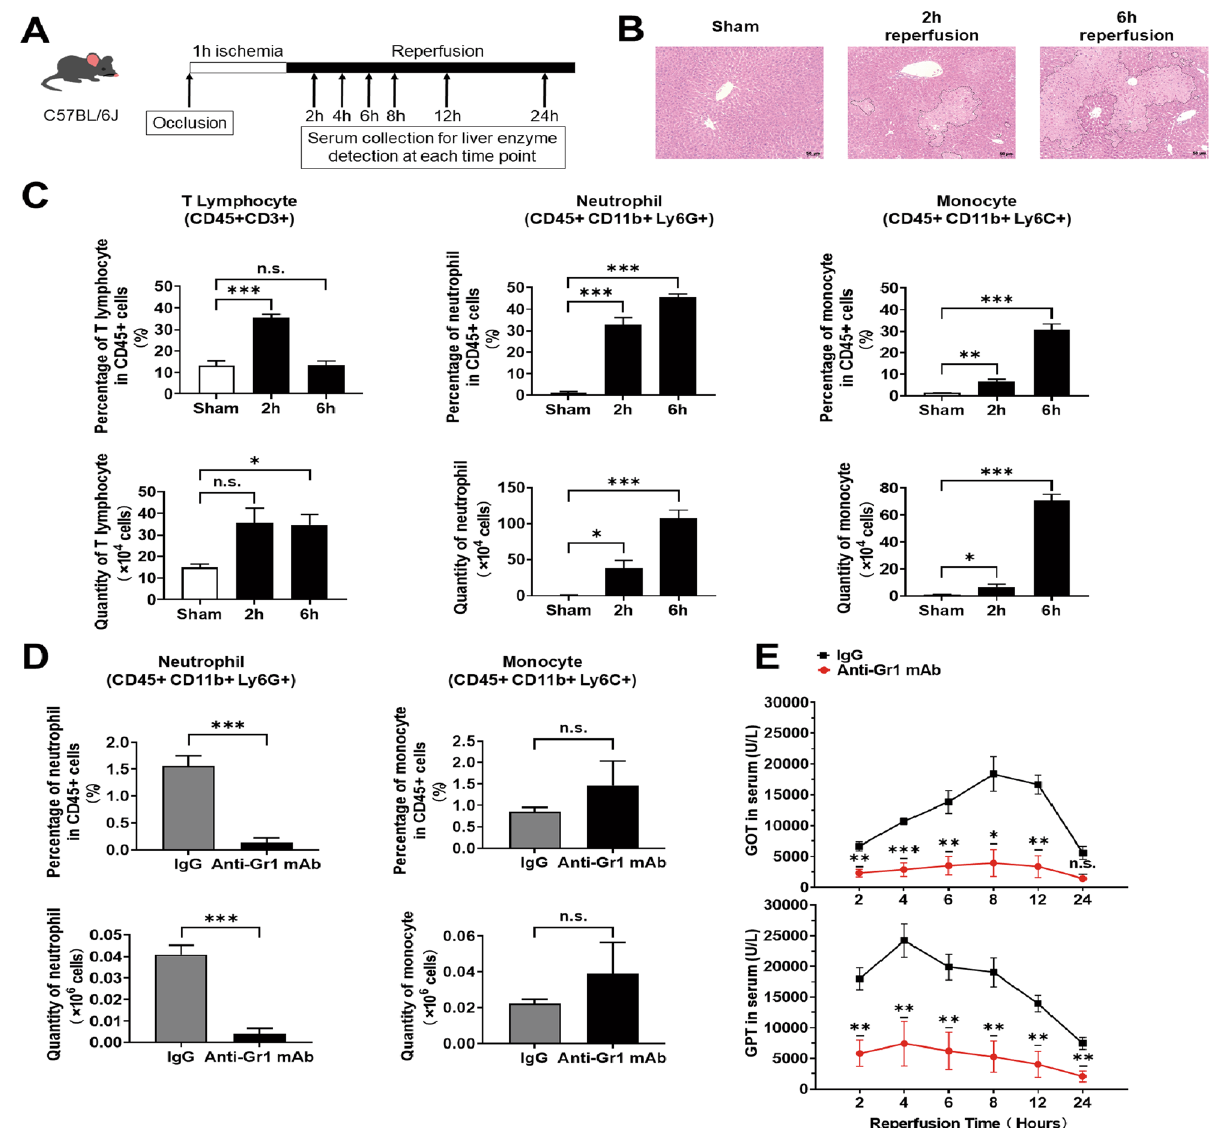
Figure 1. Hepatic IRI was alleviated by neutrophil depletion. ( A ) Protocol for a murine hepatic IRI model. ( B ) Representative images of hematoxylin and eosin staining of ischemic liver at indicated time after reperfusion. Necrosis areas are surrounded by dashed line. Image of the liver of the sham-operated mice were not distinguishable between 2 and 6 h after the sham-operation, thus the image of the liver at 6 h after sham-operation is demonstrated. ( C ) Percentage and the number of intrahepatic infiltrating T lymphocytes, neutrophil and monocyte in ischemic livers at 2 h and 6 h after reperfusion (n = 3–5 in each group). ( D ) Mice were treated with anti-Gr1 mAb at 6 and 4 days before the experiments, and PBMCs were obtained promptly before the experiments to confirm neutrophil depletion. Percentage and number of neutrophils and monocytes in PBMCs of anti-Gr1 mAb-treated and control (rat IgG2b)-treated mice are presented (n = 3 in each group). ( E ) Sera were collected at the indicated time after reperfusion from the hepatic IRI mice treated with anti-Gr1 mAb or control rat IgG2b. Then, serum GOT and GPT levels were examined. n = 3 mice in each group. *P < 0.05, **P < 0.01, ***P < 0.001. n.s. not significant. Results are presented as Means ± standard error of the mean (SEM) (C to E). Data derived from at least N = 2 independent